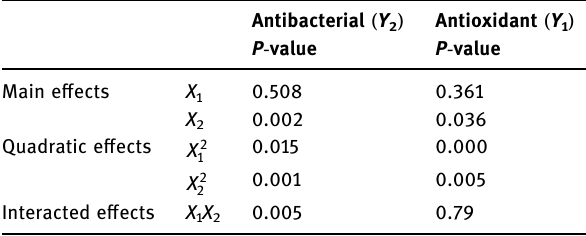
Table 4: P - value of the regression coe ffi cients in the obtained models